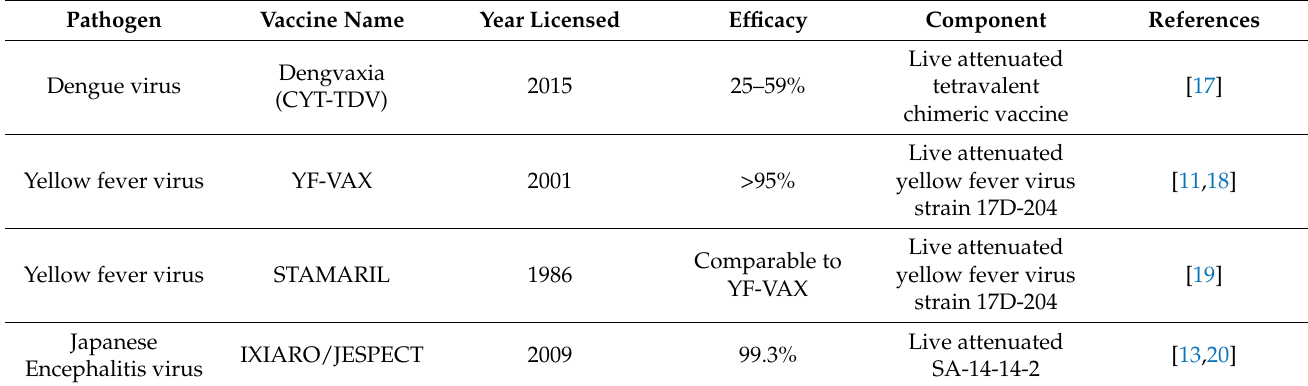
Table 1. List of current licensed vaccines against arboviruses.